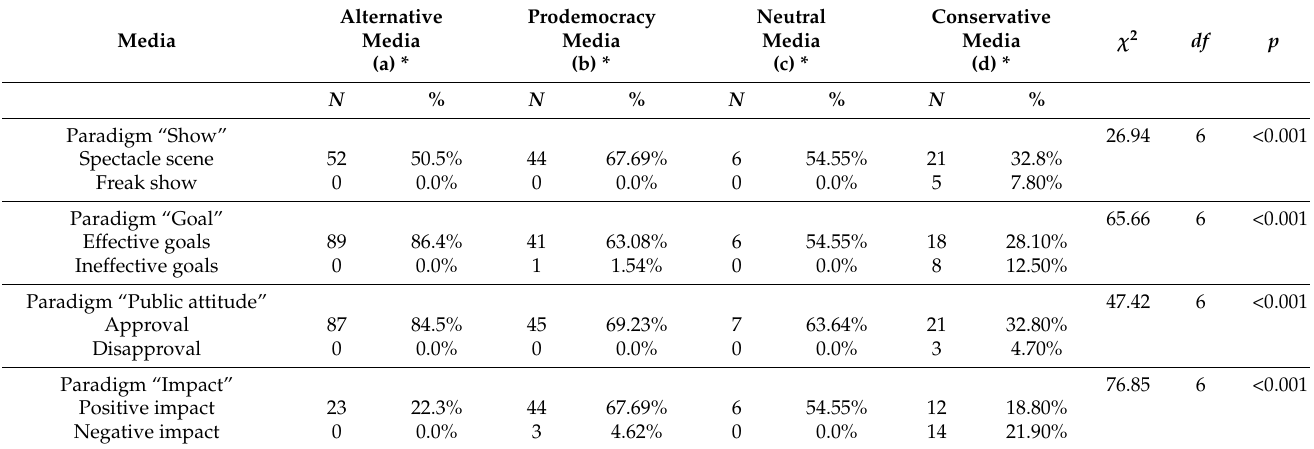
Table 6. Chi-square of “Protest Paradigm” in the protest